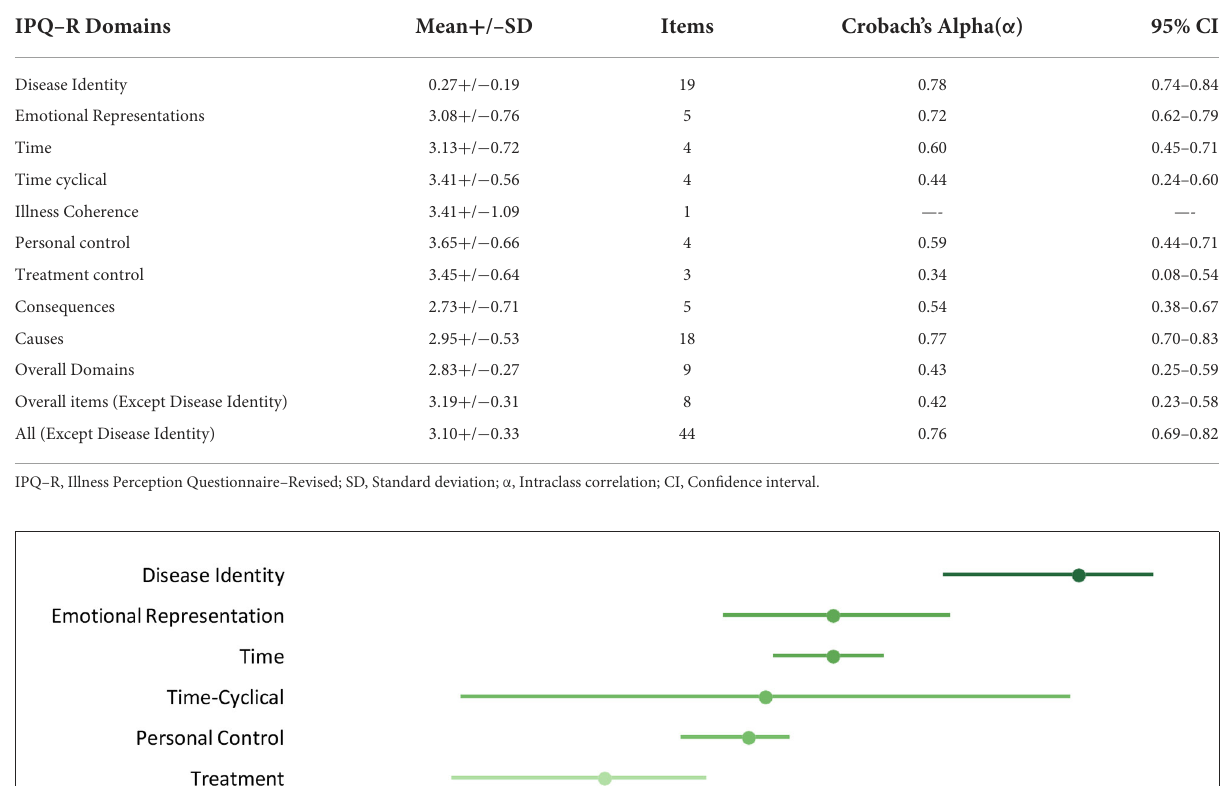
TABLE 2 Descriptive Statistics of IPQ-R Domains ( n = 100).